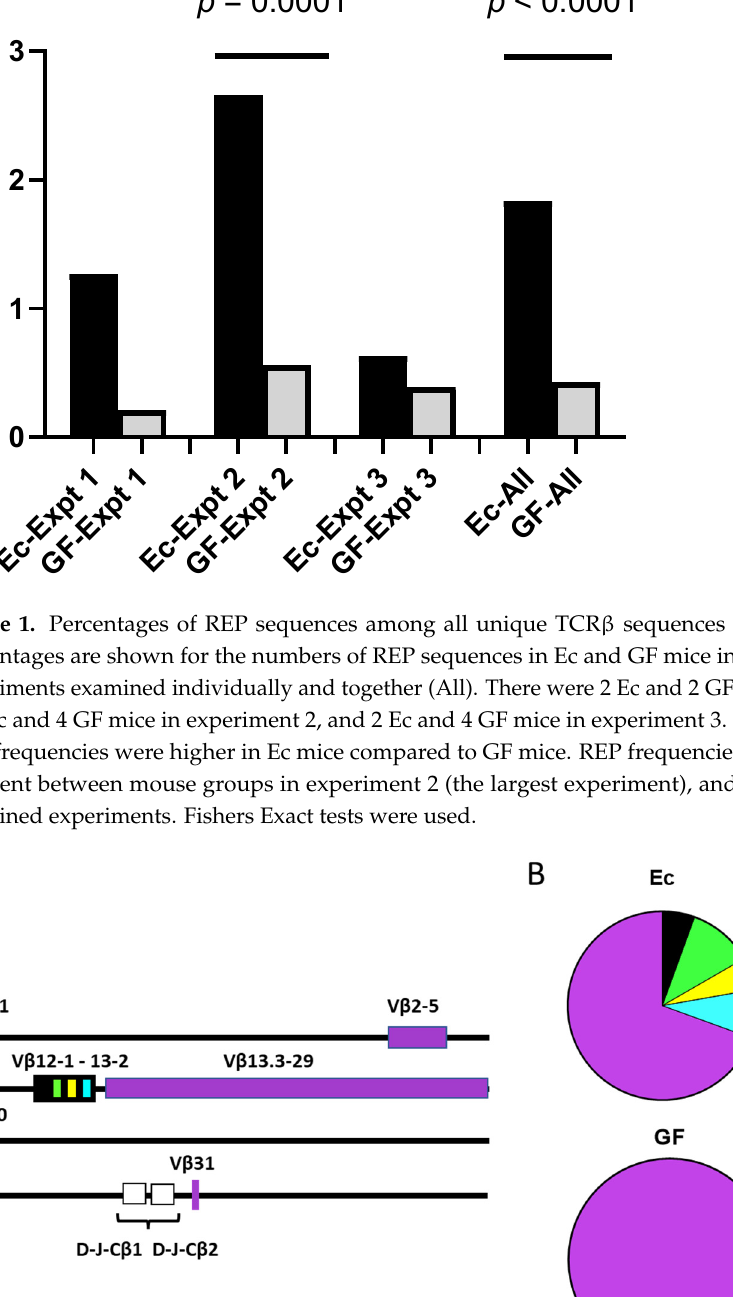
Figure 2. TCR V β 12-13 usage among REP sequences in Ec and GF mice. ( A ) V β gene positions in the murine TCR β loci. Maps were based on information from the IMGT website [3]. V β genes in the 12-13 cluster are color-coded (black, green, yellow, blue) and the remaining genes are shown in purple. D β , J β , and C β genes are shown in white. ( B ) The frequencies of V β 12-13 sequences within REP sequences among Ec (n = 36 total sequences) and GF (n = 11 total sequences) mice are shown with color-coding. ‘Other’ refers to all REP V β sequences outside of the 12-13 cluster (purple). As shown in Figure 3, an analysis of TCR V α genes was also performed. There are three sets of TCR V α genes, a consequence of evolutionary duplication [3]. In Figure 3A, these sets are labeled distal, central, and proximal, and are separated by red stars.